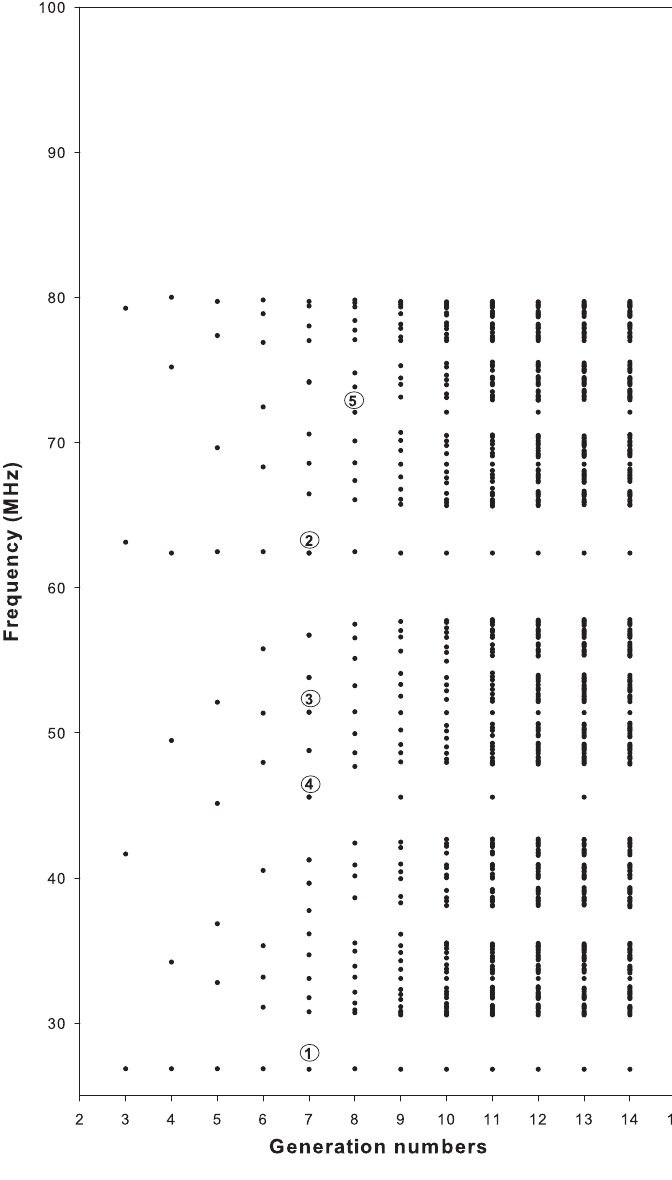
Figure 7. Dispersion of the eigenfrequencies (dots) of different generation numbers. The boundary conditions on both sides of the Fibonacci sequence (FS) are H = 0. One can notice the existence of primary and secondary gaps. All the discrete modes are obtained from the maxima of the transmission spectra displayed in Figure 6. The labels 1, 2, 3, 4 and 5 represent the surface